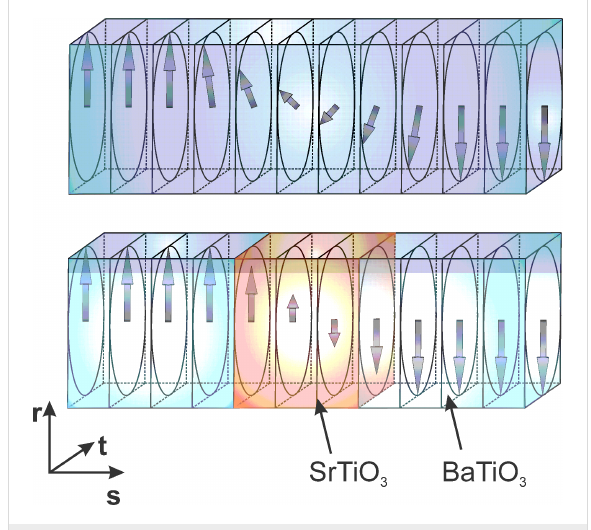
Figure 2: Schematic illustration of polarization passing across the 180- degree domain wall in pure rhombohedral BaTiO 3 and in the superlat- tice containing 1 nm thin SrTiO 3 layers. Note the almost Ising-like profile in the bottom panel.